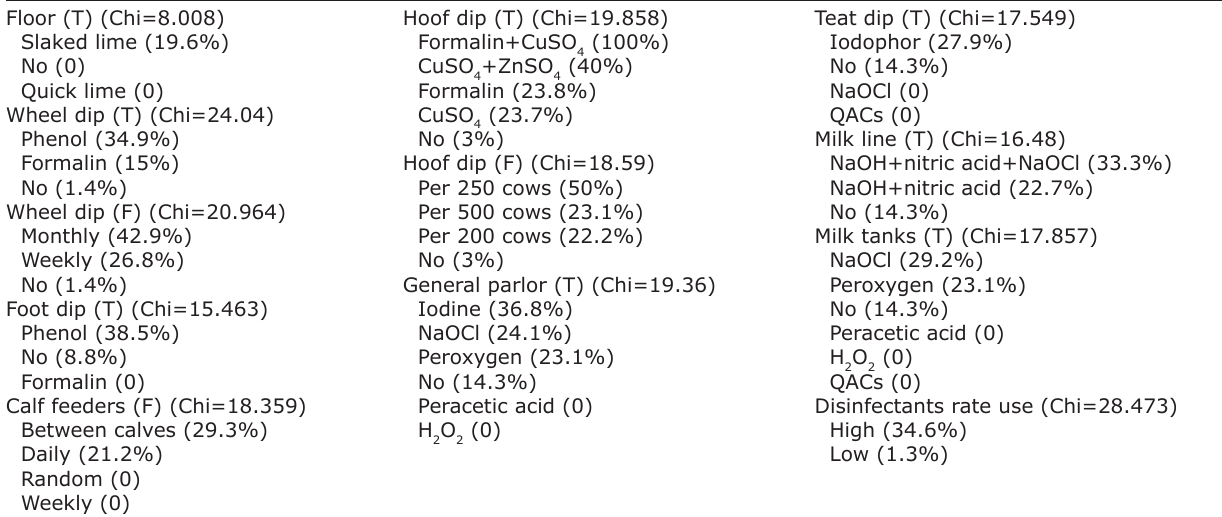
Table-5: Chi-square value and percent of resistant strains presence in descending order for each significant disinfectant type (T) and frequency (F) of use or change. Floor (T) (Chi=8.008) Slaked lime (19.6%) No (0) Quick lime (0) Wheel dip (T) (Chi=24.04) Phenol